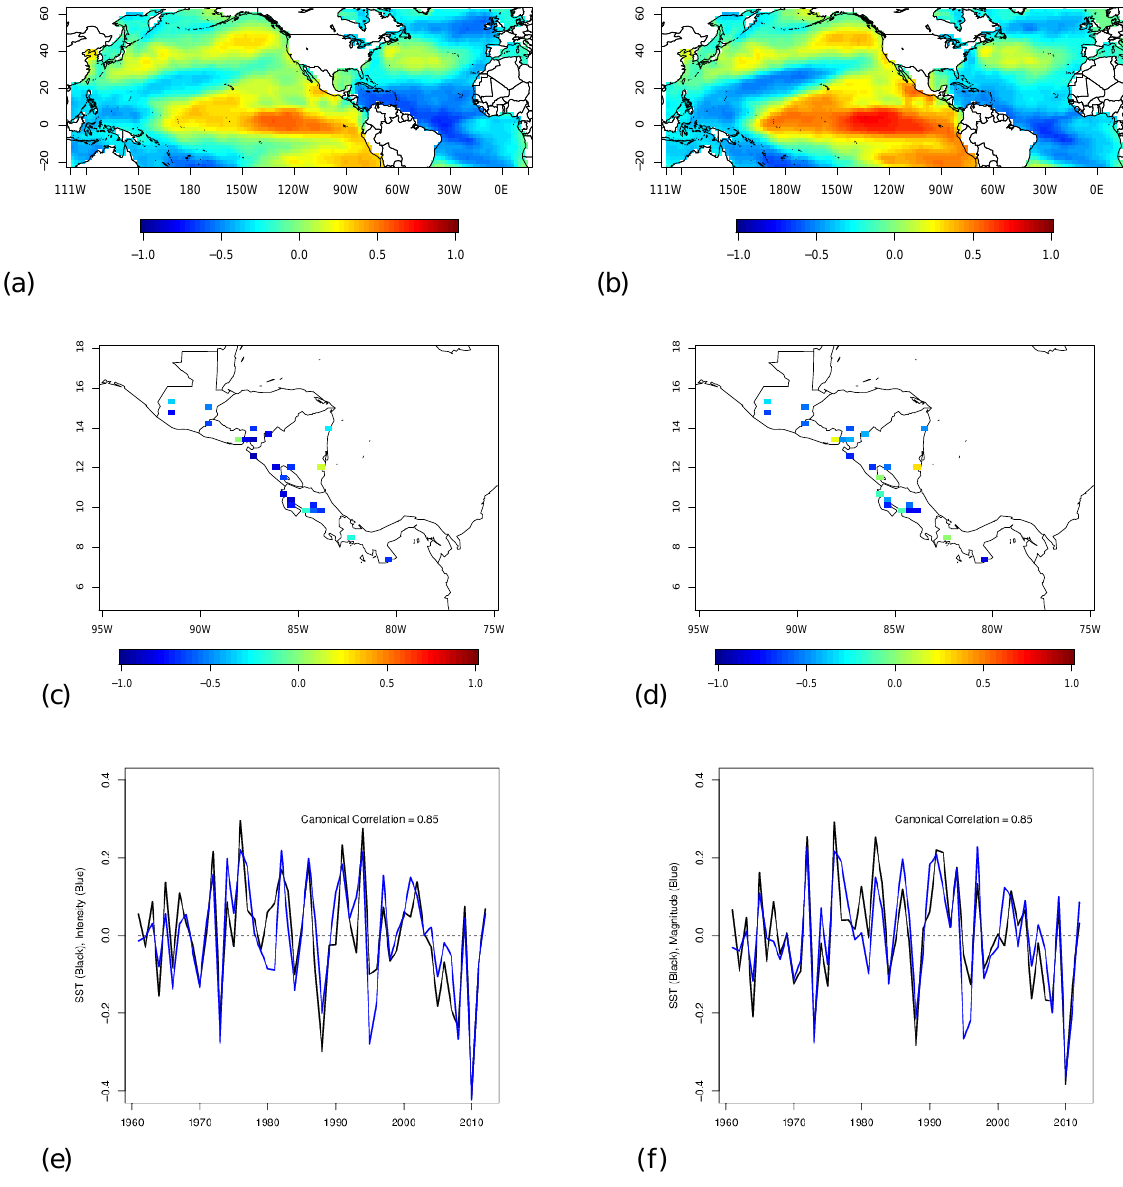
Figure 9. CCA mode 1 for both MSD intensity and magnitude. In the left column are the X (upper) and Y (middle) loadings, and the time scores (bottom) for the intensity. In the right column the same but for the